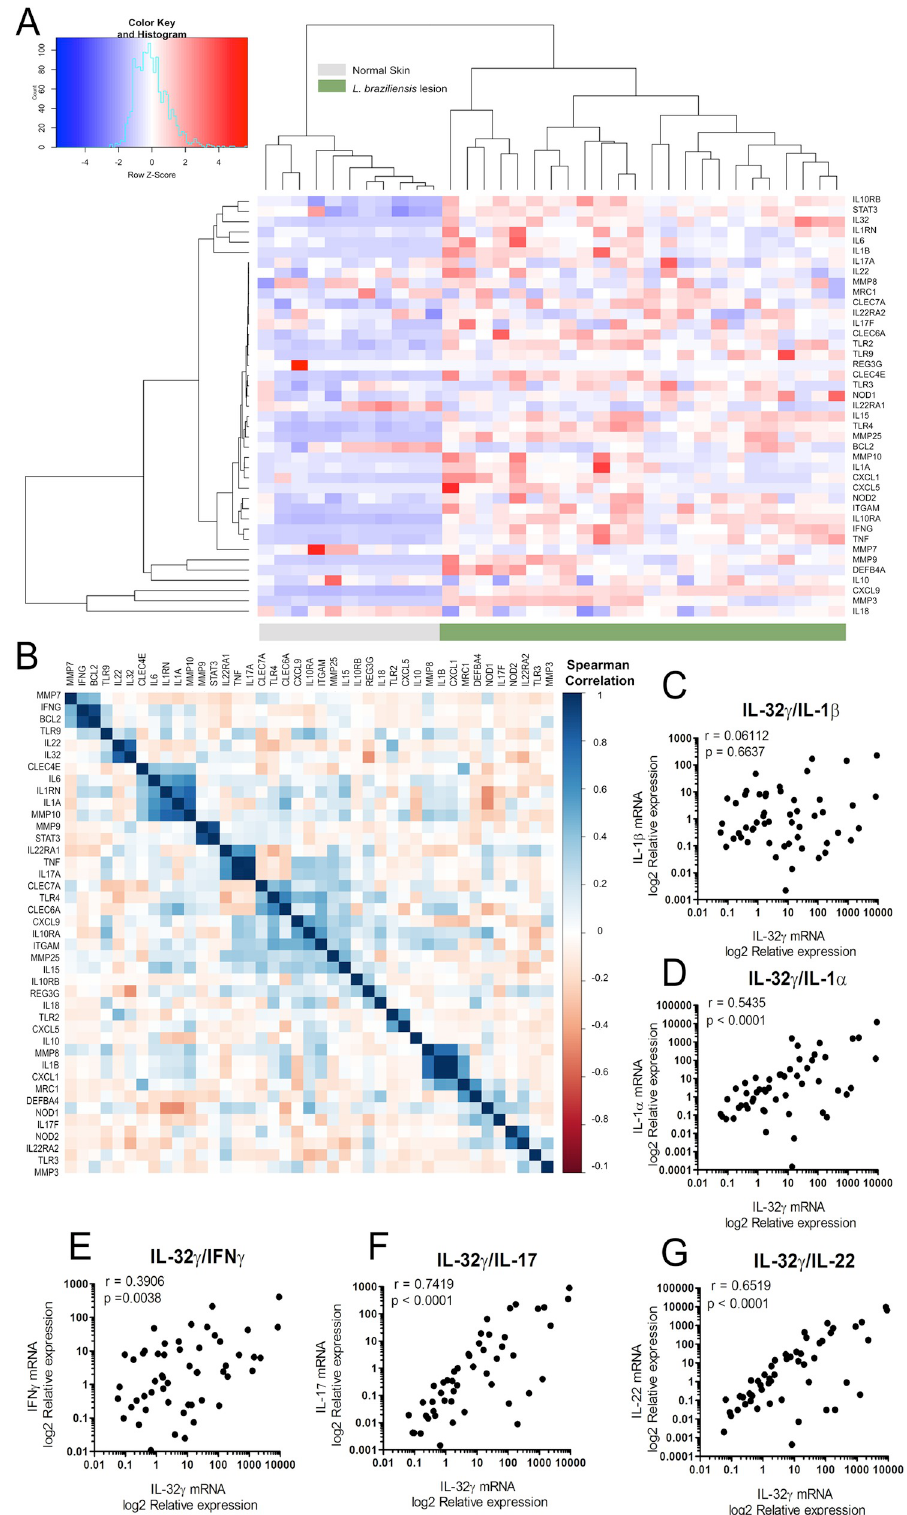
Fig 6. (A) Heatmap showing the expression of selected genes in normal skin versus cutaneous lesions from patients infected with L . braziliensis described in [42]. Columns represent individual patients and rows represent